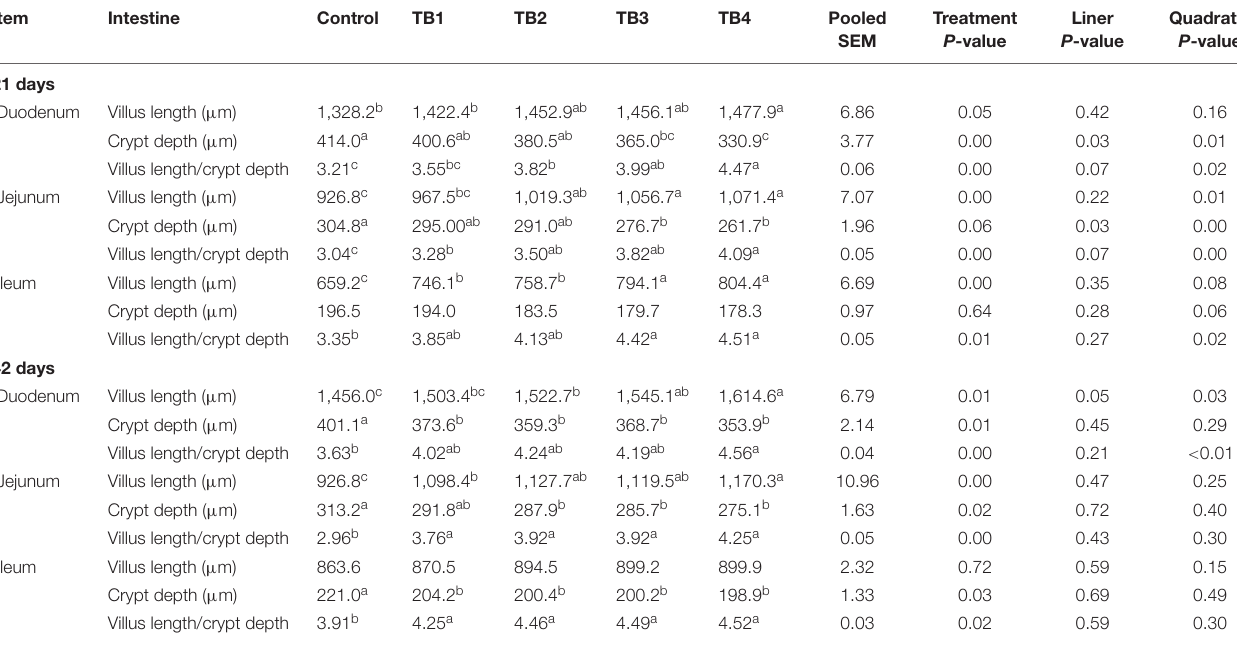
TABLE 3 | Effect of dietary TB on histomorphology of the small intestinal sections in